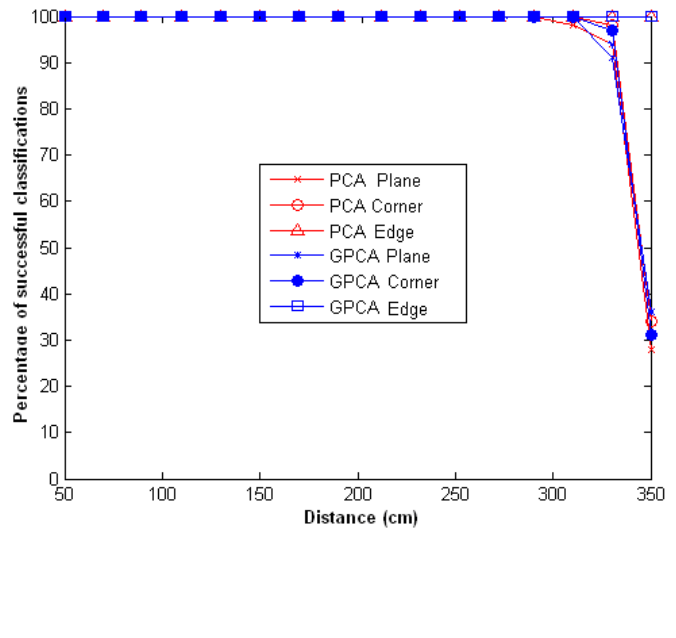
Figure 6. Percentage of successful classifications using GPCA and PCA, for l = l and m =